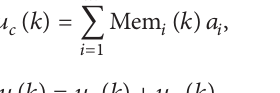
where 𝑐 is the generalization parameter of network or the number of associative units. The total output is equal to the sum of CMAC output and PID output ( 𝑢(𝑘) = 𝑢 𝑝 (𝑘)+𝑢 𝑐 (𝑘)) . In order to make the difference of the total output and CMAC output tend to zero, the output 𝑢 𝑝 (𝑘) of PID control network should tend to zero.